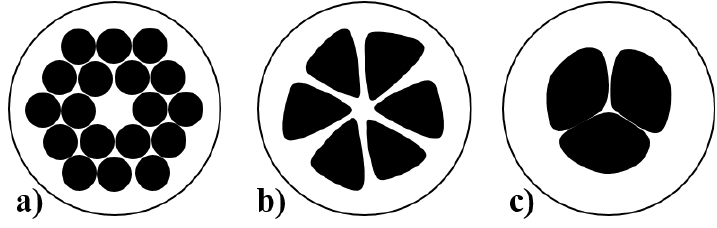
Figure 2. Microstructered optical fibers; ( a ) Hollow core; ( b ) Grapefruit; and ( c ) three-hole suspended